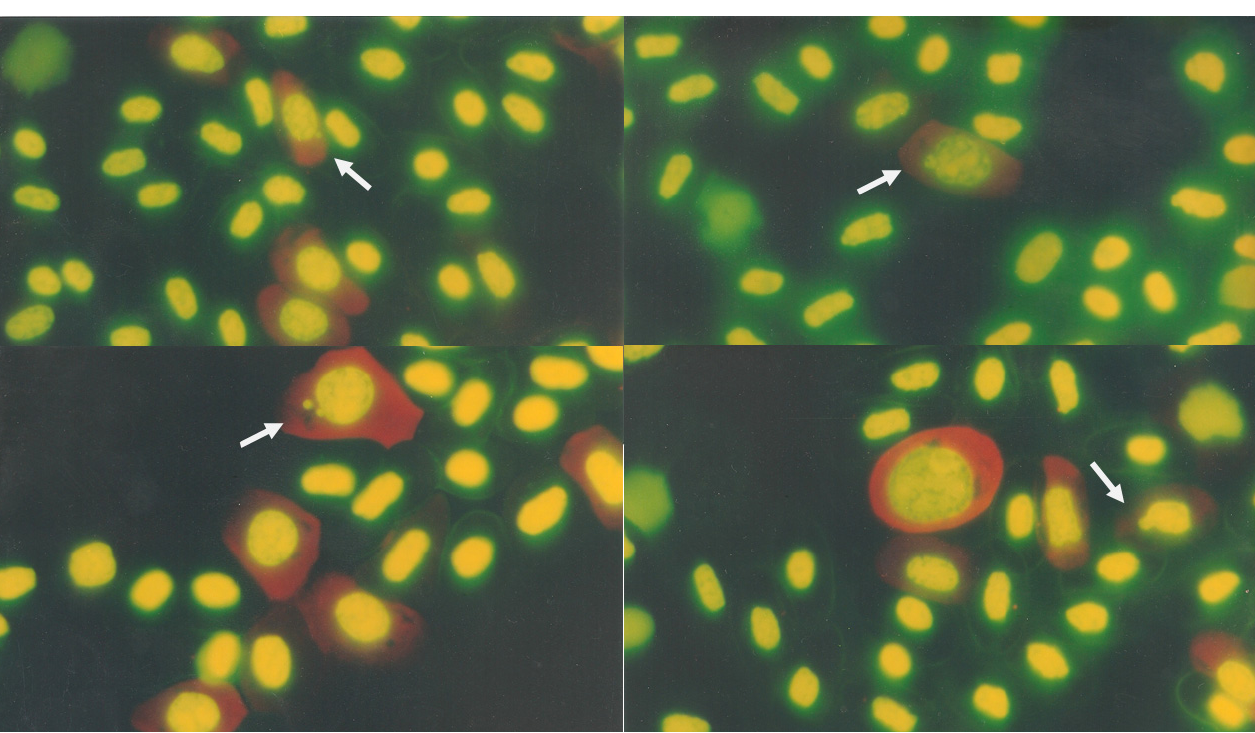
Figure 2. Young erythrocytes with micronuclei and nuclear buds in peripheral crocodile blood samples were observed.